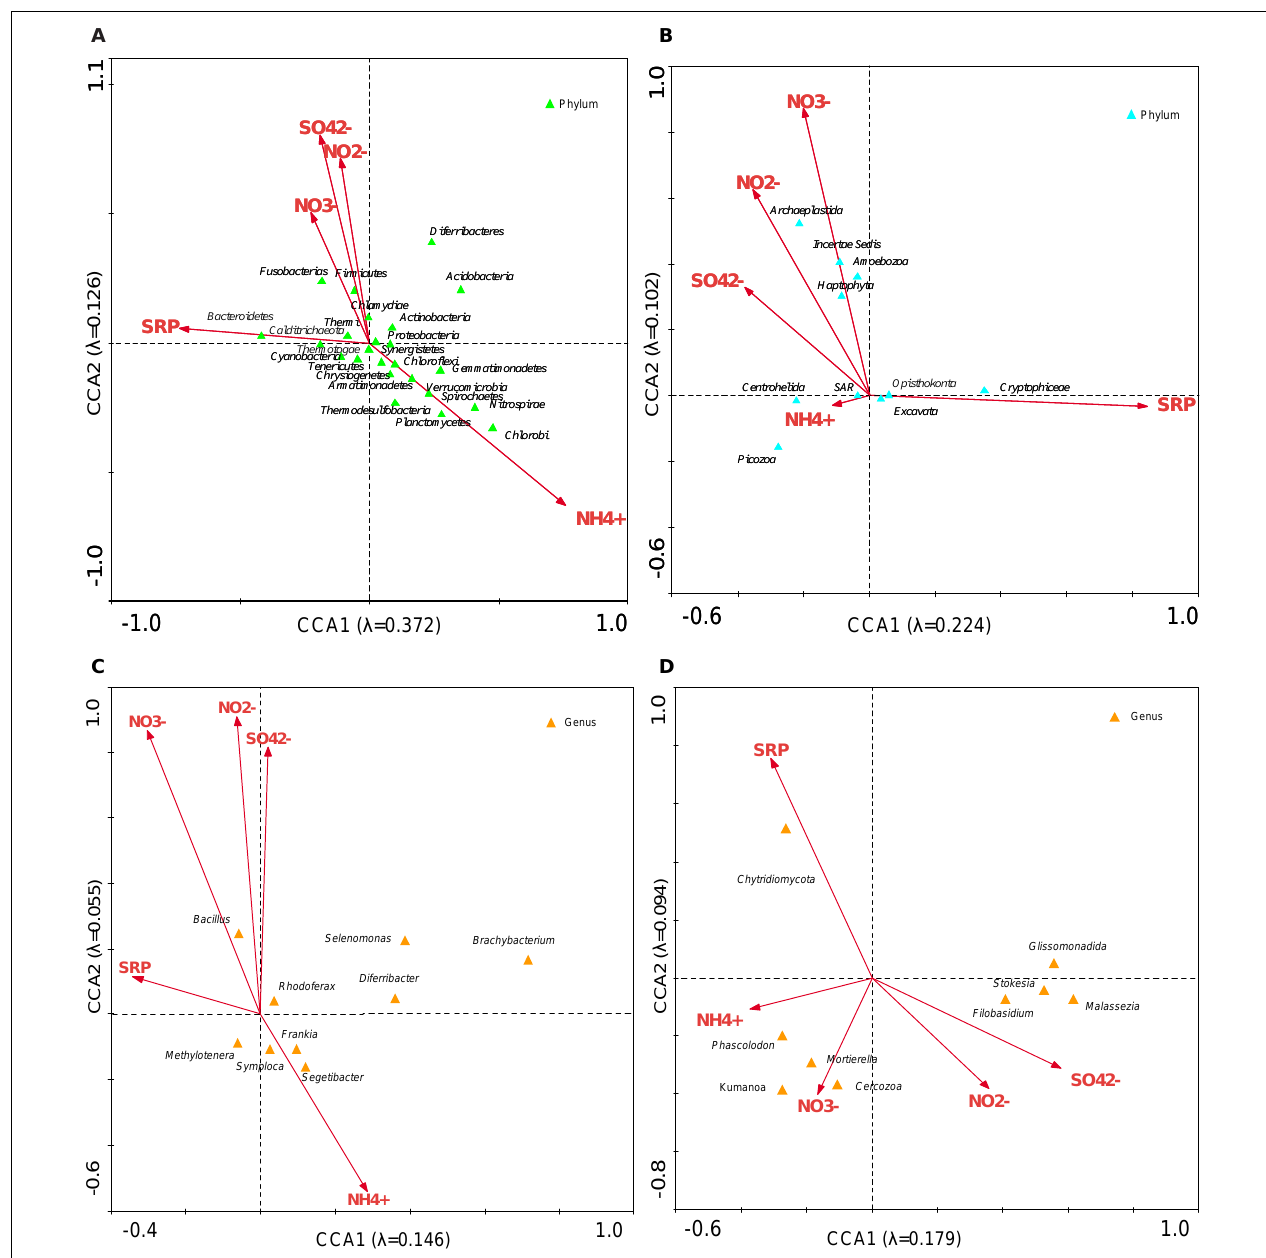
FIGURE 4 | CCA of the microbial groups with regard to the concentration of NH4 + , NO 2 − , NO 3 − , SO 42 − , and SRP. Analysis of (A) bacterial phyla, (B) eukaryotic phyla, (C) bacterial genera, and (D) eukaryotic genera with respect to concentrations. The diagram displays triangles that represent taxonomic groups and arrows that symbolize environmental variables. Correlations between microbial community and ions are represented in axes.